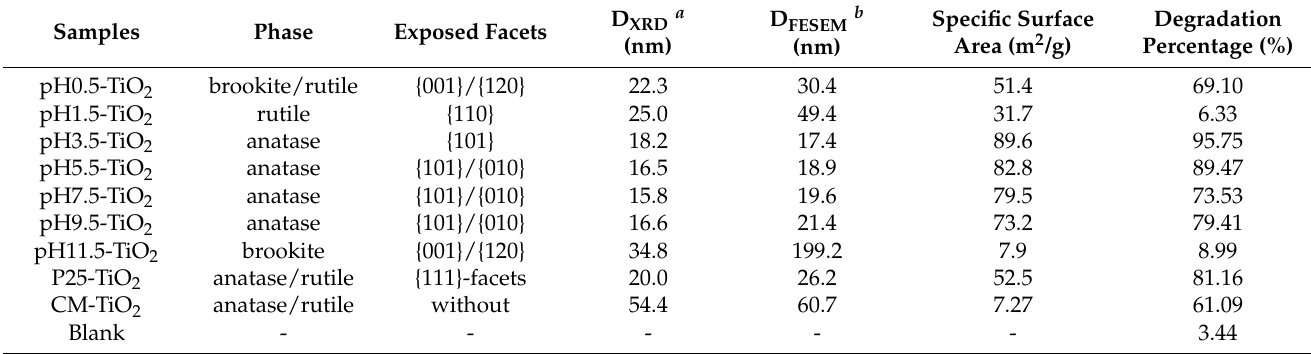
Table 1. Properties and activity parameters of the prepared and commercial TiO 2 samples.